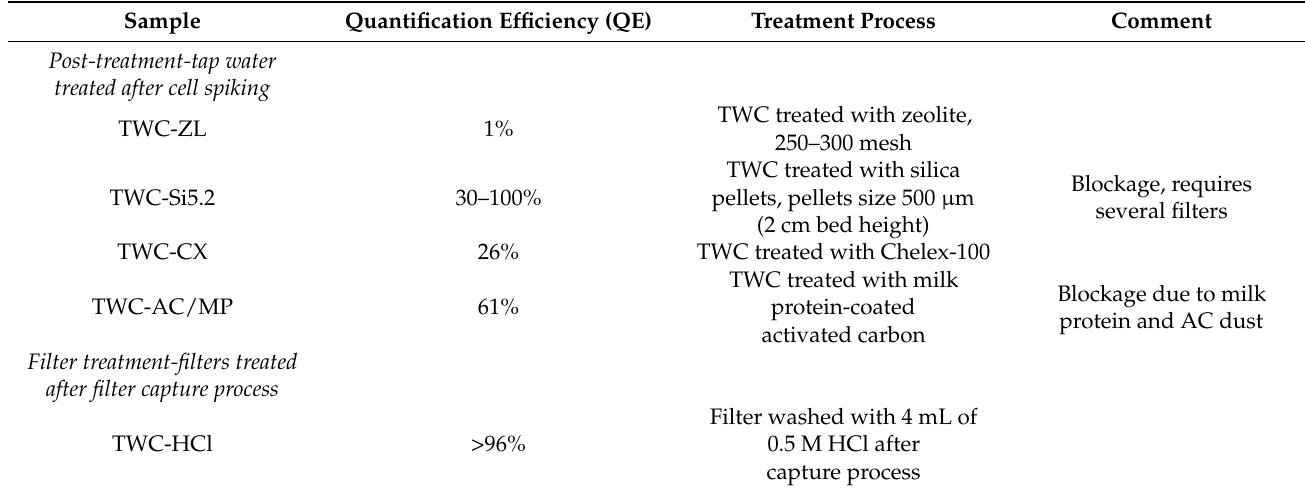
Table 5. Evaluation of the effectiveness of treatment strategies in 10 mL of spiked tap water samples. TWC—tap water with spiked C. jejuni